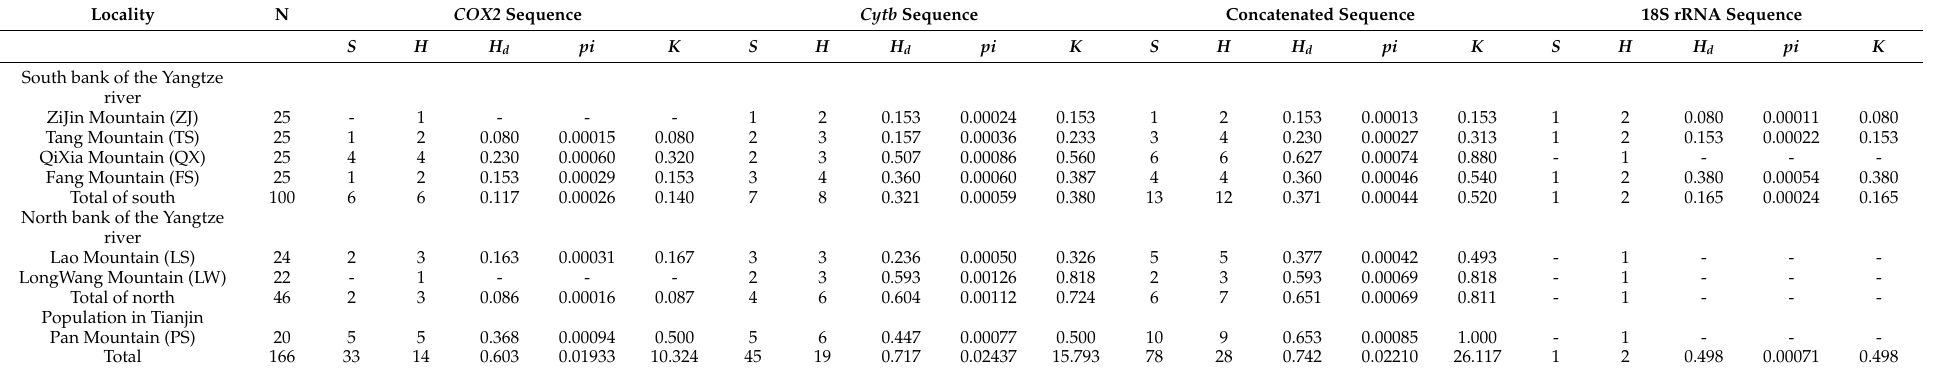
Table 1. Haplotype and nucleotide diversity for mitochondrial Cytb , COX2 , and nuclear 18S rRNA data of S. bungii